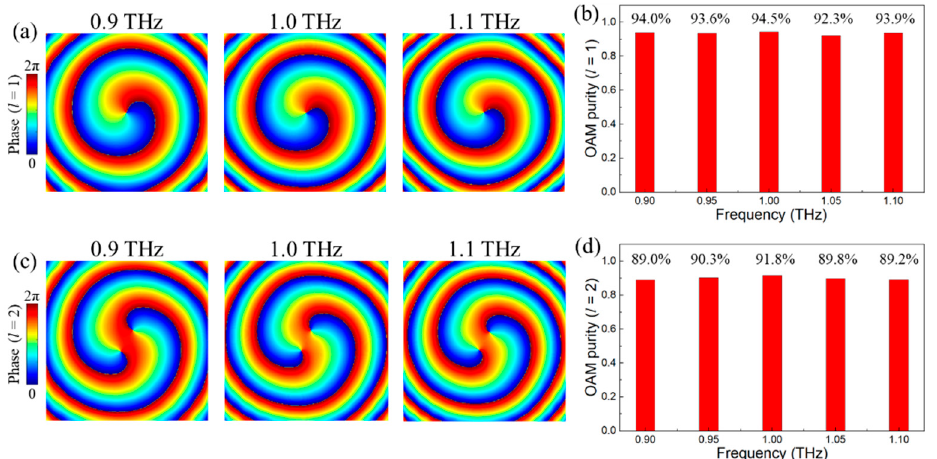
Figure 13. ( a ) and ( c ) are the phase profile of the vortex beams with l = +1 and +2 at 0.9 THz, 1.0 THz